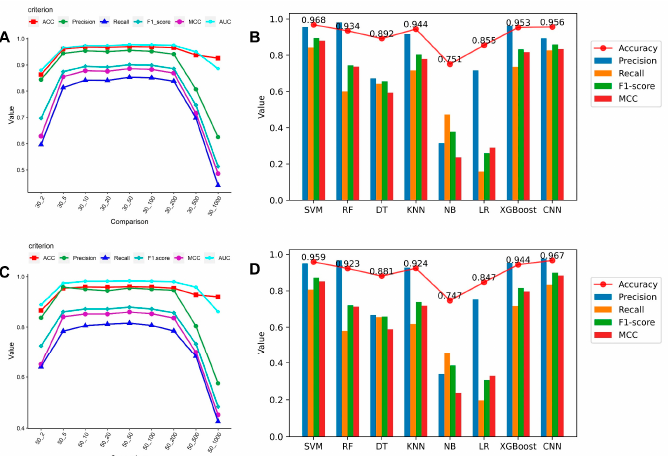
Figure 1. Line graph and histogram of sRNA sequence specificity verification using machine learning: ( A ) The SVM performance trend at x times change in the 30 RPM value data set. ( B ) The evaluation result of each machine learning model at the 10 times change in 30 RPM value. ( C ) The SVM performance trend at x times changes in the 50 RPM value data set. ( D ) The evaluation result of each machine learning model at the 10 times change in 50 RPM value.